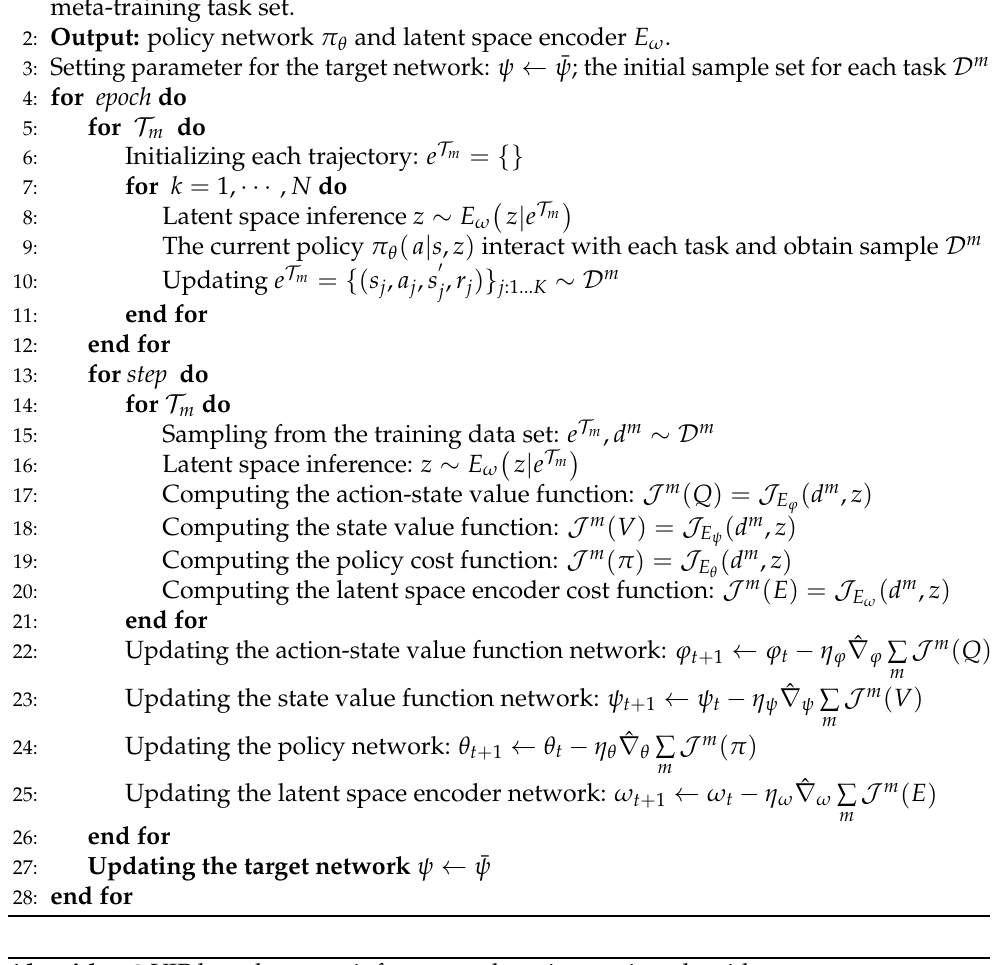
Algorithm 2 VIB based meta-reinforcement learning testing